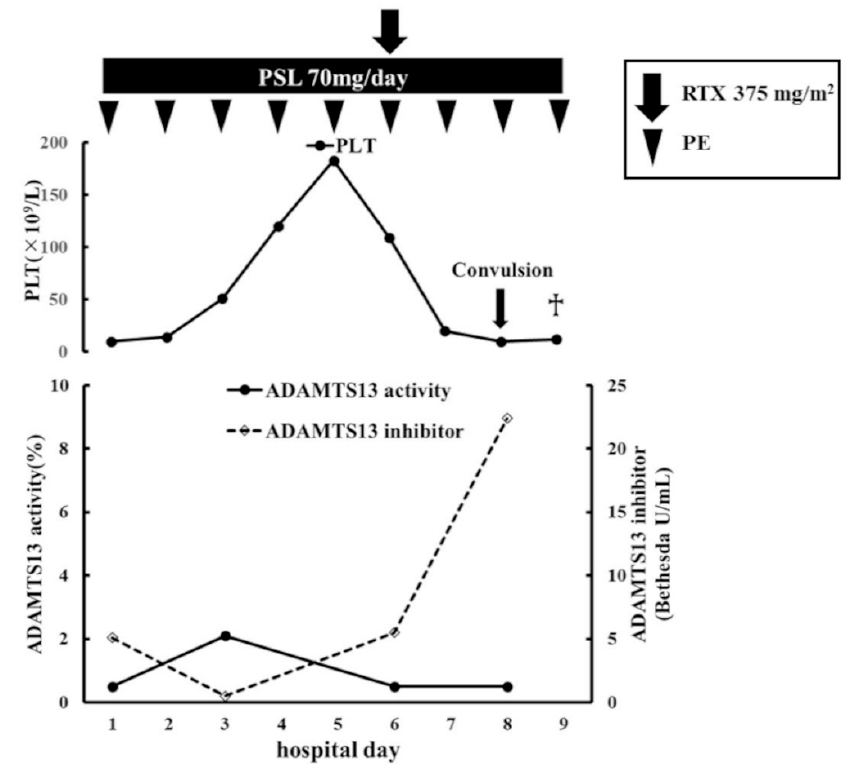
Figure 1. Clinical course of the current case after admission. The daily PE and PSL were continued and RTX was added on the 6th day. The patient’s platelet count normalized on the 5th day, but it began to decrease again on the 6th day and did not recover. Her ADAMTS13 activity only slightly recovered (to 2.1%) and her ADAMTS13 inhibitor level initially decreased, but significantly increased again after 5 days. The patient developed systemic tonic convulsions and entered the ICU on the 8th day. On the 9th day, she died of a cardiac arrest due to a sudden drop in blood pressure. PE: plasma exchange therapy; PSL: prednisolone; PLT: platelets; RTX: rituximab; BU: Bethesda units; ICU: intensive care